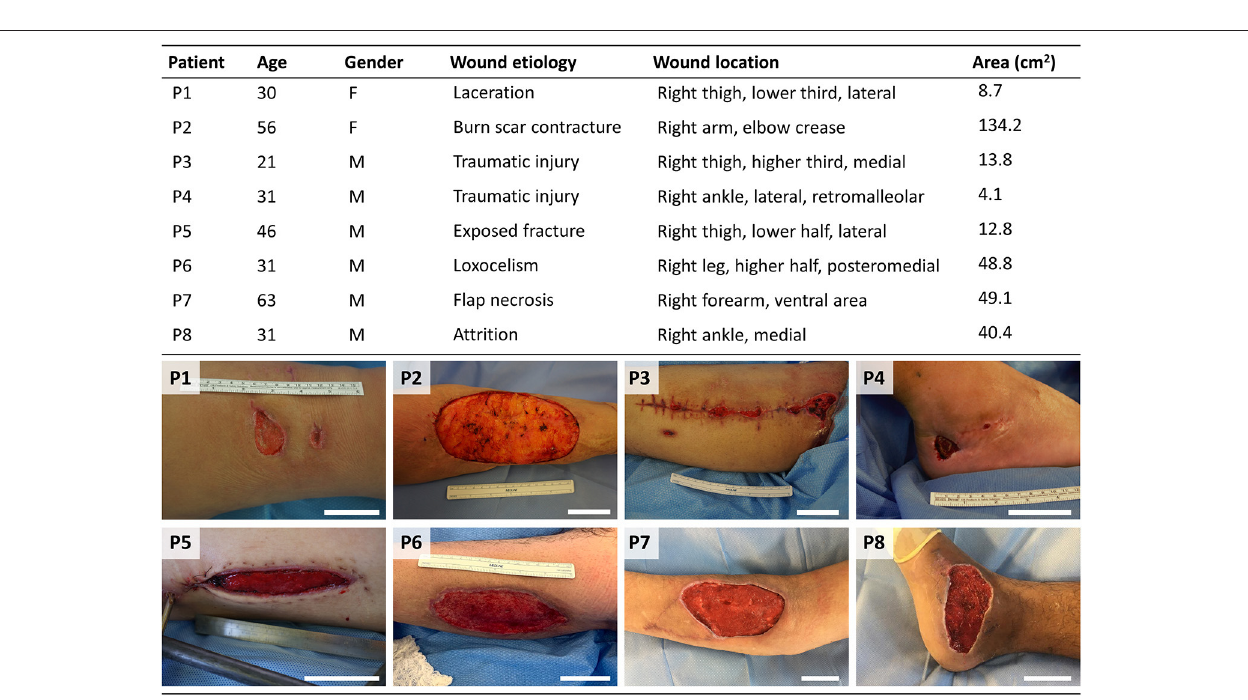
FIGURE 2 | Study design. Photosynthetic scaffolds were implanted in patients previously recruited by Hospital del Salvador, Chile. Implanted scaffolds were illuminated during the first 7 days. On day 21 after implantation, an autologous split-thickness skin graft was surgically fixed over the previously implanted photosynthetic scaffold. All patients were evaluated and observed for up to 90 days. Blood and biopsy samples were taken at time points indicated in the figure.